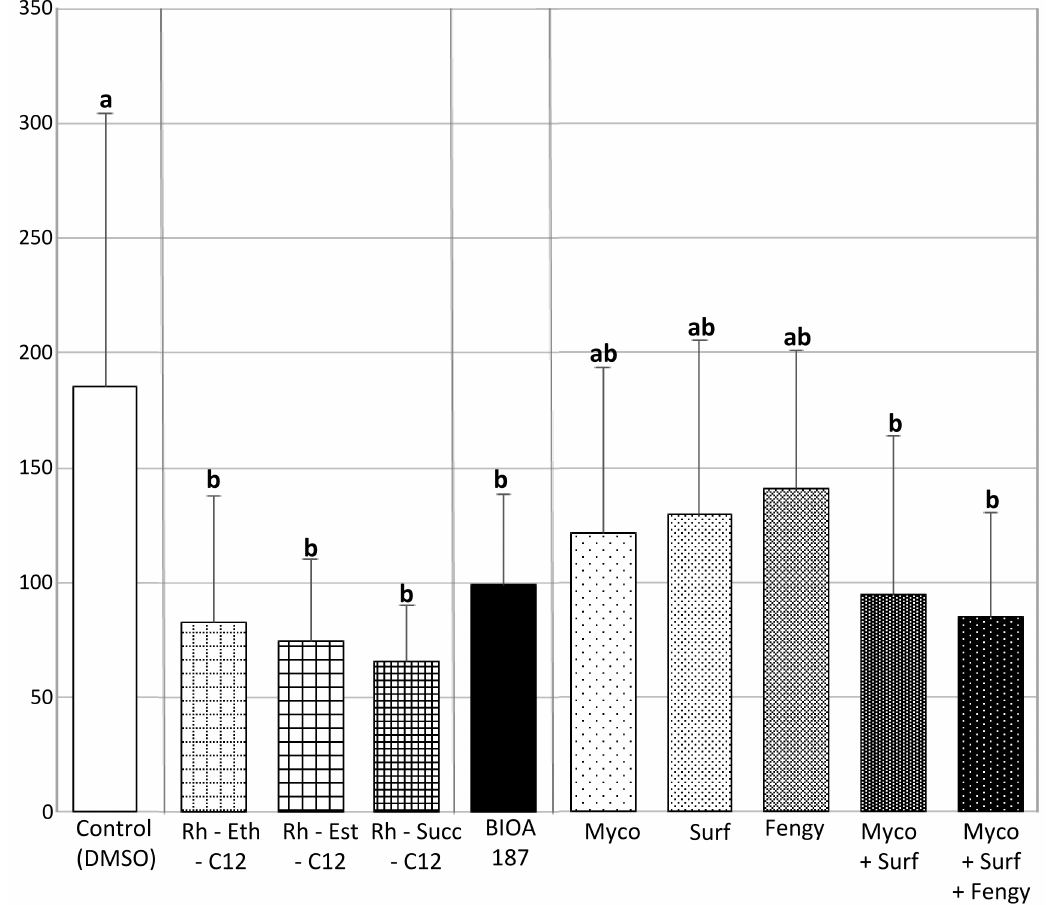
Figure 4. Average number of fungal colonies estimated on the third leaf of 24 plantlets of wheat cultivar Pakito 12 days after infection by B. graminis f.sp. tritici ( Bgt ) in each condition. Plants were sprayed with the various treatments and inoculated by Bgt (5 × 10 5 spores/mL) 2 days after the treatment. Data represent means of 3 independent experiments. Values with different letters are significantly different (ANOVA, p ≤